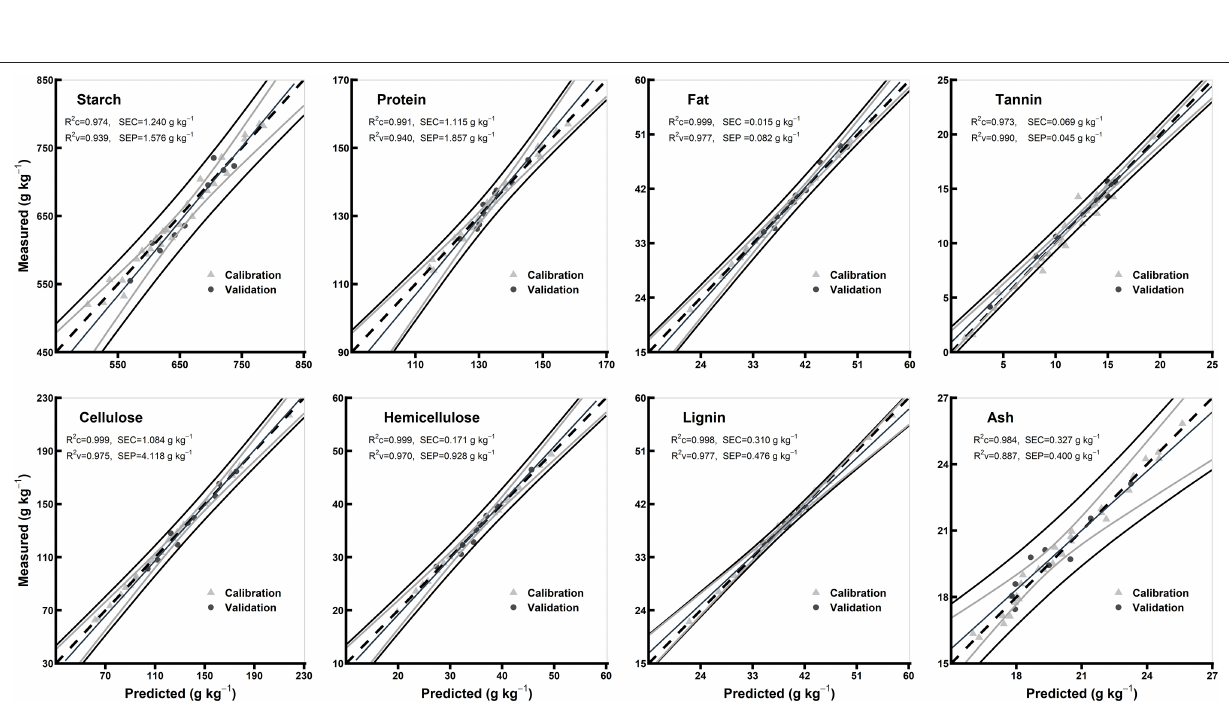
FIGURE 7 | Comparison of scatter plots of measured vs. predicted values (g kg − 1 ) of the hull-less grain flours for starch, protein, fat, tannin, cellulose, hemicellulose, lignin, and ash of sorghum grains for the external validation subsets based on PLSR models. The black and gray lines in plot showed mean, maximum, and minimum values while dotted lines showed average chemical composition between calibration and validation sample